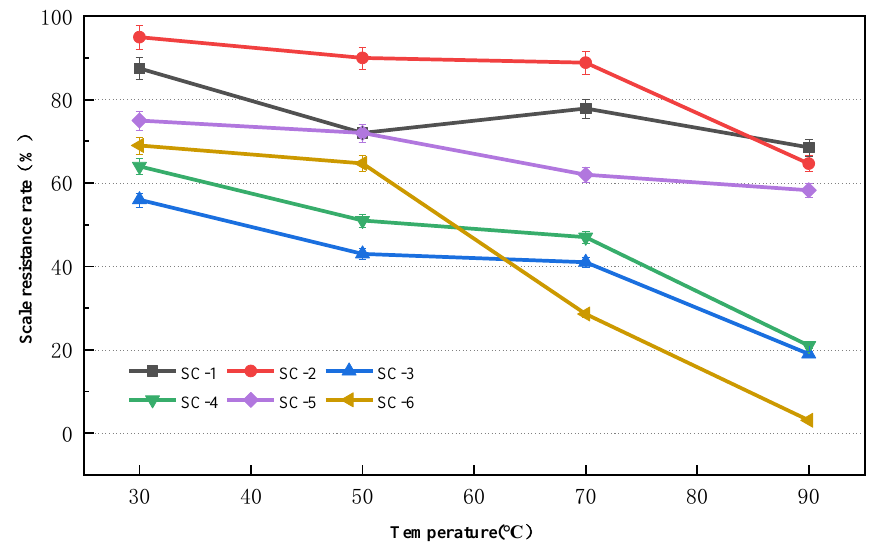
Figure 3. Effect of scale inhibitor on calcium carbonate at different temperatures at pH of 7.